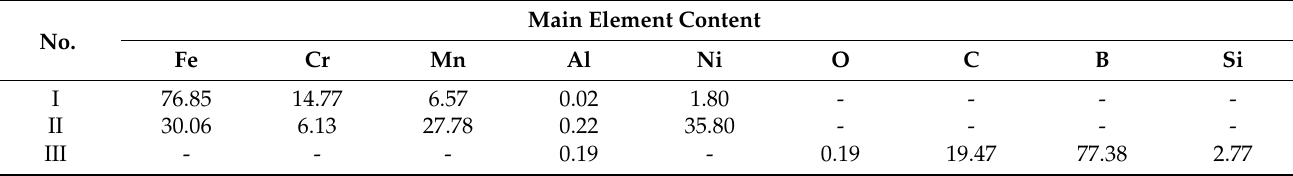
Figure 6. Schematic diagram of the deposition process of the coating. 3.5. Coating Microhardness Figure 7 shows the microhardness distribution curve of the coating along the cross- section. The coating hardness fluctuates considerably, from 1431 Hv 0.1 to 1730 Hv 0.1 , mainly due to the aggregation and uneven distribution of Al 2 O 3 , B 4 C, and Fe 3 B hard phase. The average microhardness of the coating is 1543 ± 145 Hv 0.1 , which is eight times higher than that of the low-carbon steel. Combined with XRD and EDS analysis, there are three reasons for the relatively high hardness of the coating. Firstly, the (Fe, Cr) solid solution resulted in lattice distortion, thereby preventing the movement of crystal boundaries and dislocations, and played a solid solution strengthening effect [42,43]. Secondly, hard phase particles of Al 2 O 3 , B 4 C, and Fe 3 B were dispersed in the coating, which plays a dispersion- strengthening effect. Thirdly, the small amount of amorphous phase structure in the